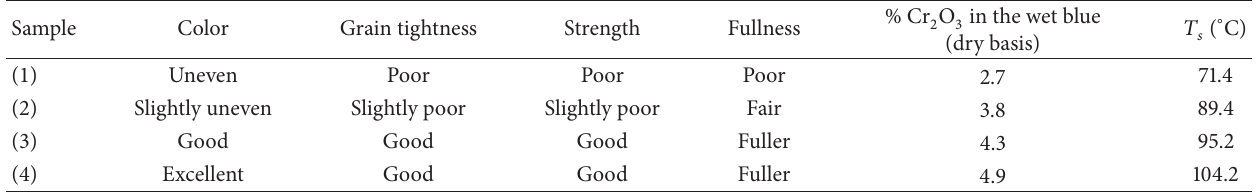
Table 3: Properties of the tanned